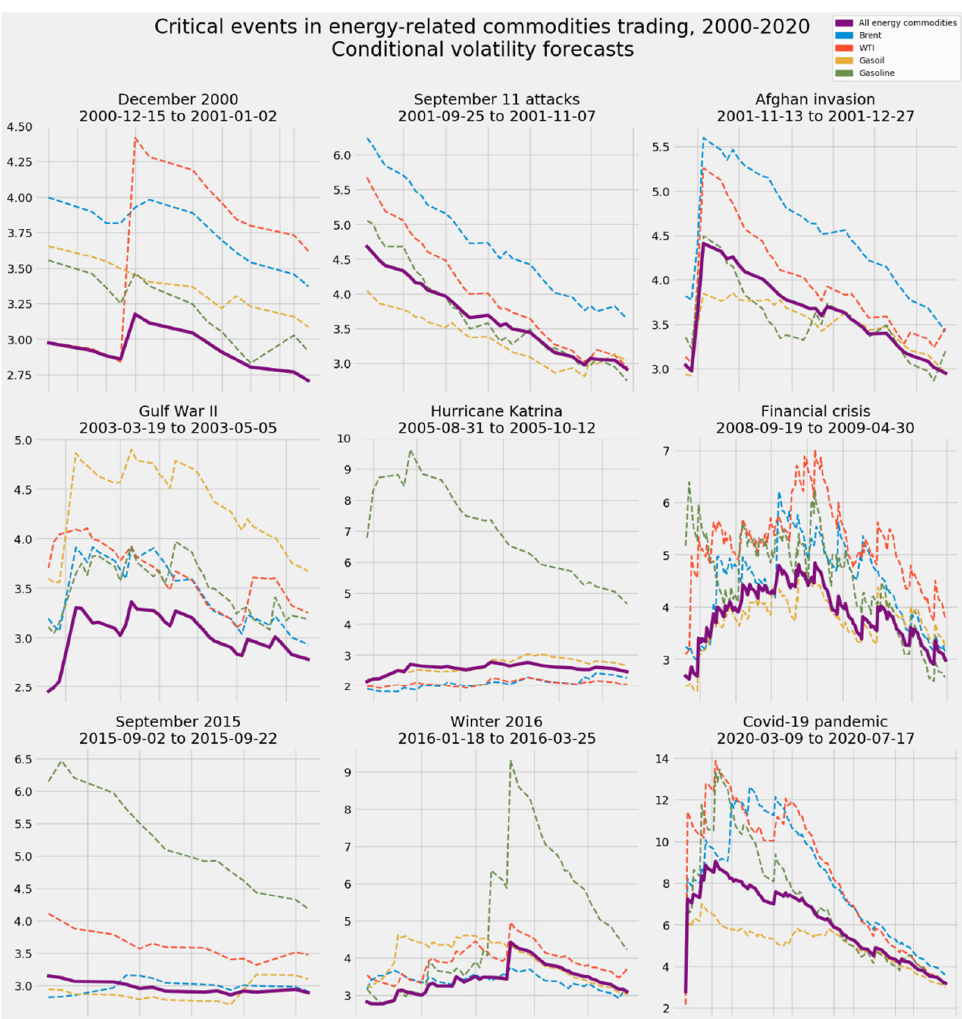
Figure 38. Conditional volatility forecasts during critical periods for an equally weighted market basket of four oil and fuel commodities, with details for each of the constituent markets.